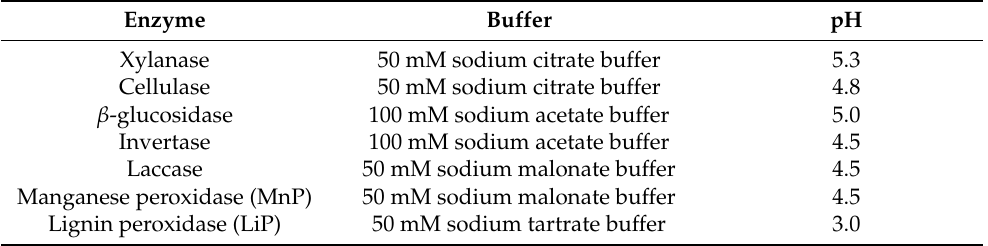
Table 1. Buffer for the preparation of extracts for the measurement of enzyme